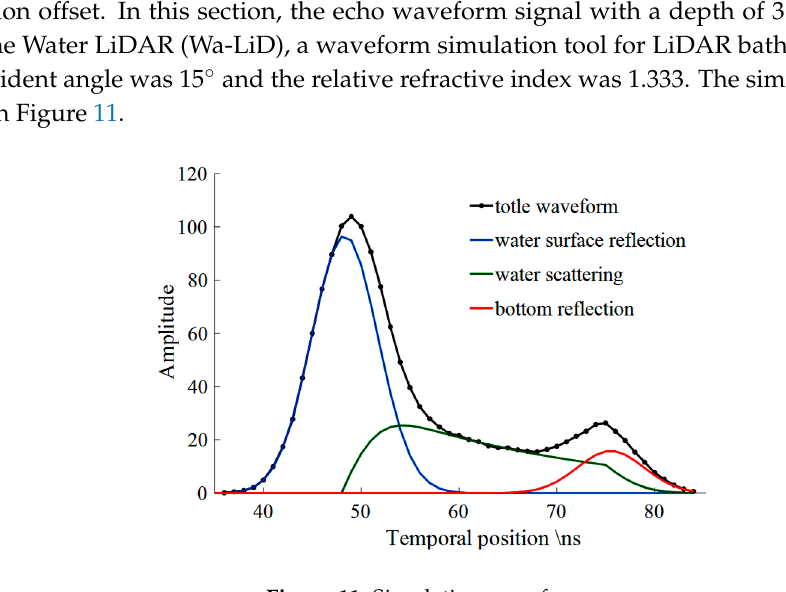
Figure 11. Simulation waveform.